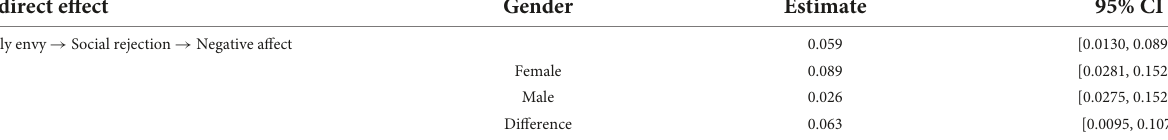
TABLE 3 Results of indirect and conditional indirect effects from the multilevel path analysis. Indirect effect Gender Estimate 95%